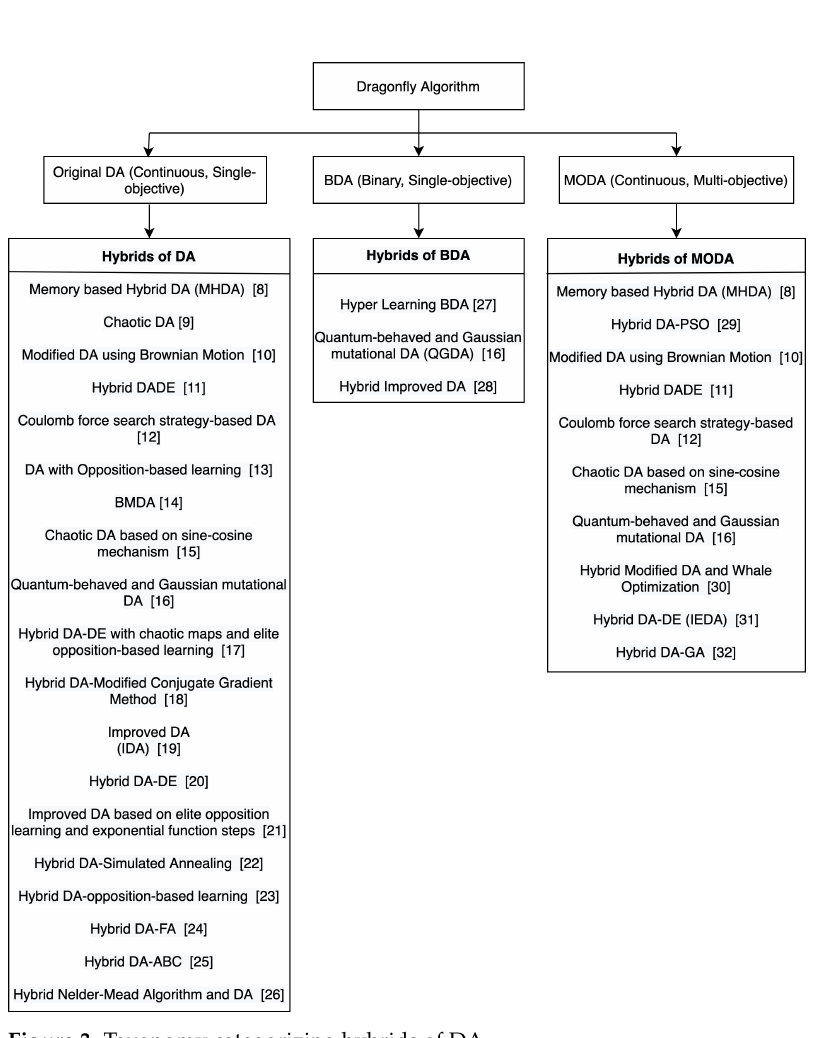
Figure 3. Taxonomy categorizing hybrids of DA.